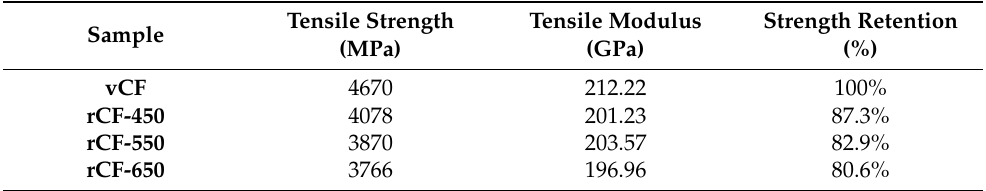
Table 3. The tensile properties of virgin and recycled carbon fibre.